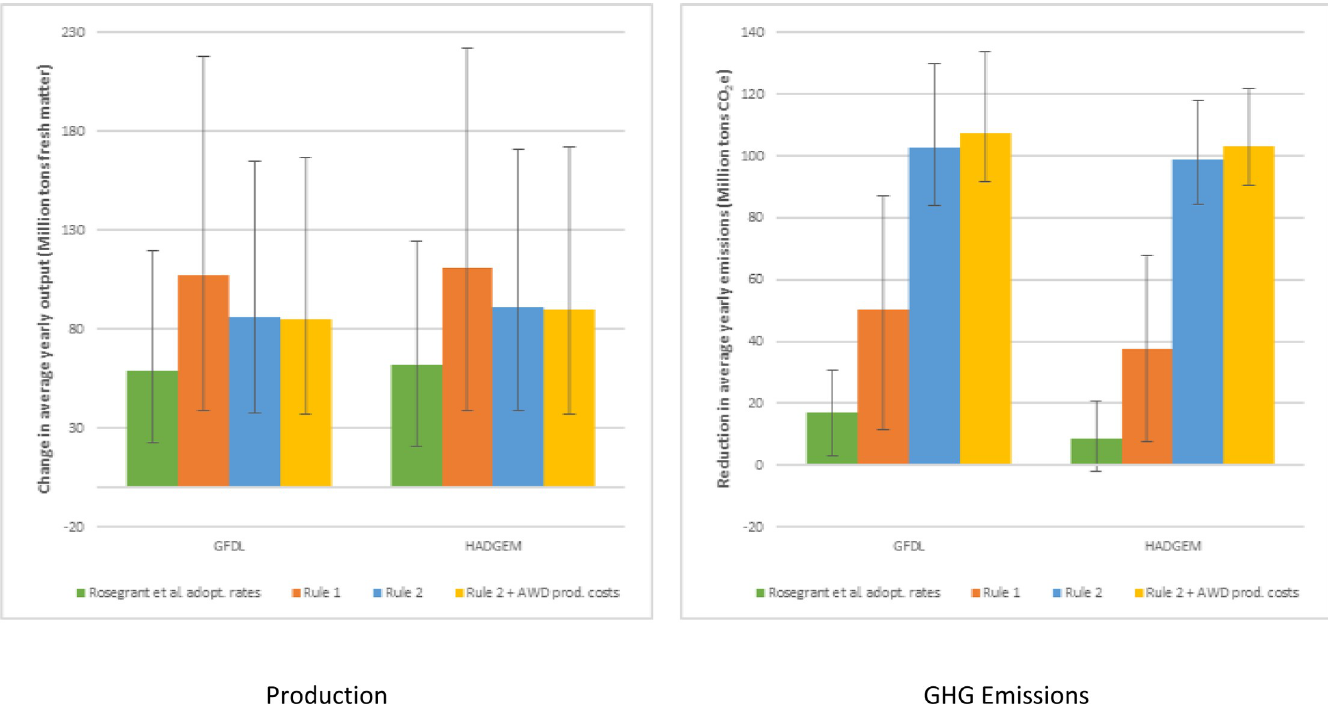
Fig 4. Changes in average yearly cumulative production of maize, rice and wheat and GHG emissions for alternative scenarios for the period 2010–2050. Columns indicate the average tailoring of CSA practices; whisker bars identify results for the poor and optimal tailoring Source: Authors.